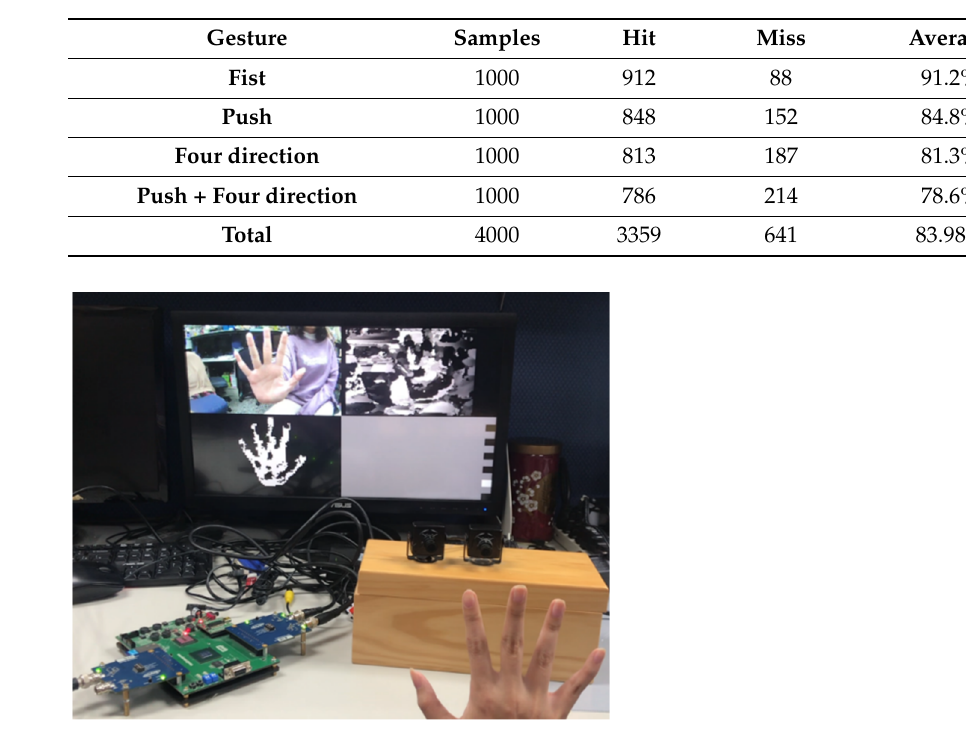
Figure 14. The resource usage of FPGA. Table 3. The recognition rate of the proposed system.